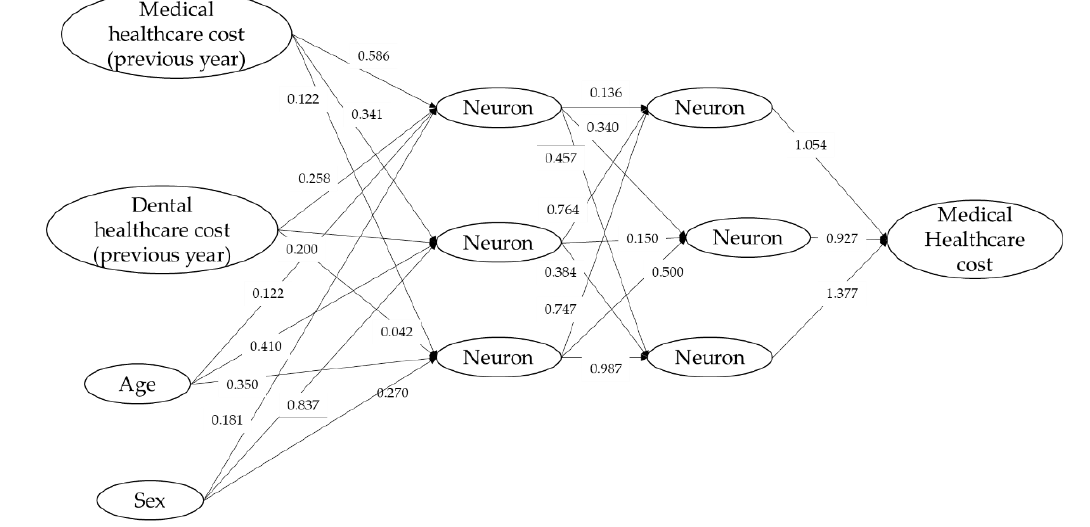
Figure 5. Predictive performance of the neural network model ( A ), support vector machine regression ( B ), and generalized boosted regression modeling ( C ). Predictive performance was shown by the scatter plot of the predictive value against the observed value. Figure 6. Response surface of the prediction of the medical healthcare cost by the medical healthcare cost of the previous year and dental healthcare cost of the previous year.